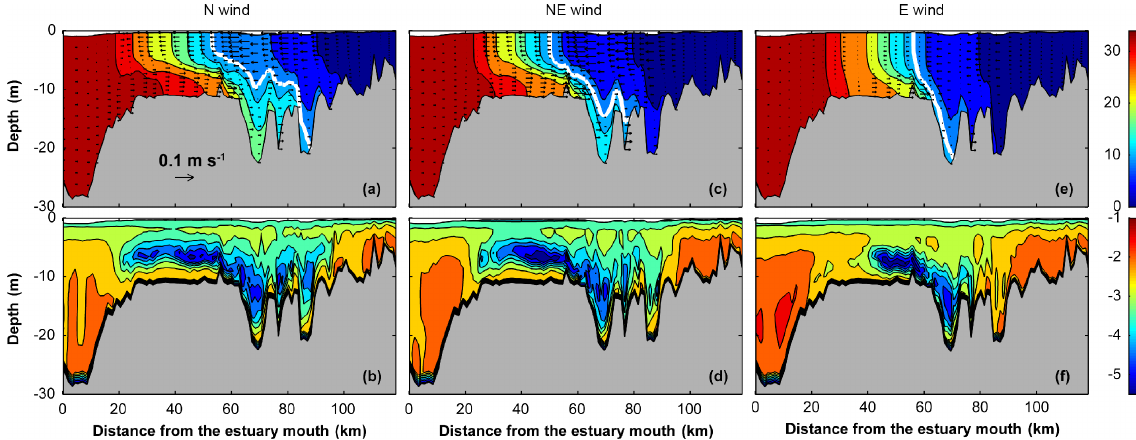
Figure 14. Comparison of 50h of averaged salinity (units: ppt), current (units: ms − 1 ) and log 10 of eddy diffusivity along the longitudinal section (T1) under different wind directions. The white line shows the 10ppt isohaline. The top panels (a, c, e) show salinity and axial current, while the bottom panels (b, d, f) show log 10 of the eddy diffusivity.